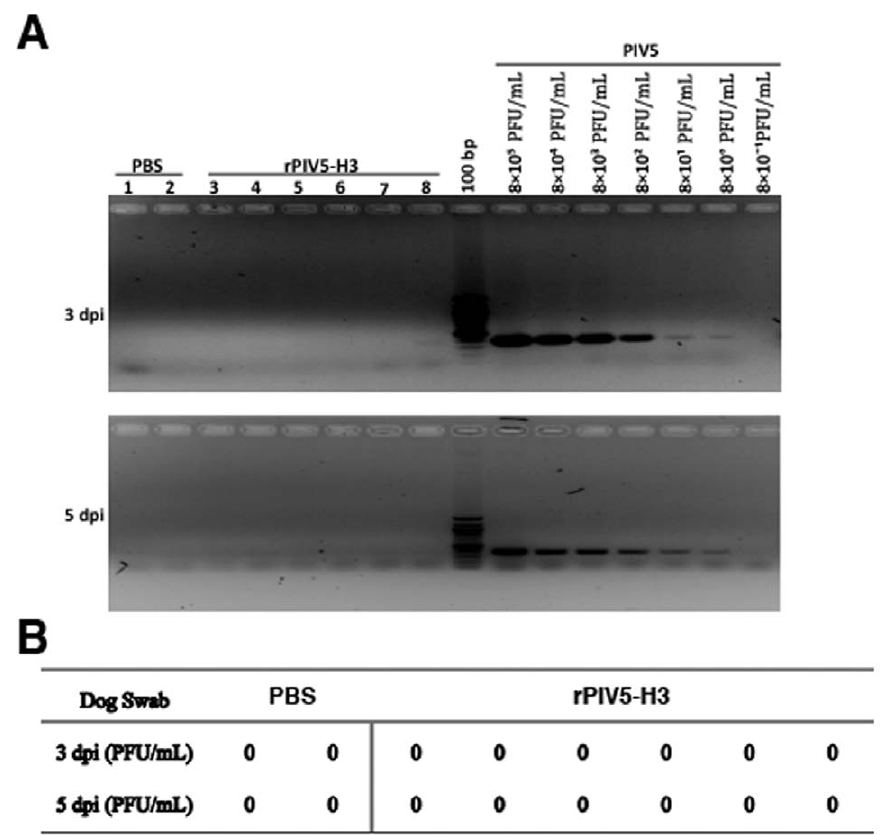
Figure 5. Replication of PIV5 in dogs with prior PIV5 vaccination. The nasal swabs of dogs were collected at 3 and 5 dpi. Detections of virus were performed the same as in Fig. 2. (A) RT-PCR and (B) Plaque assay.